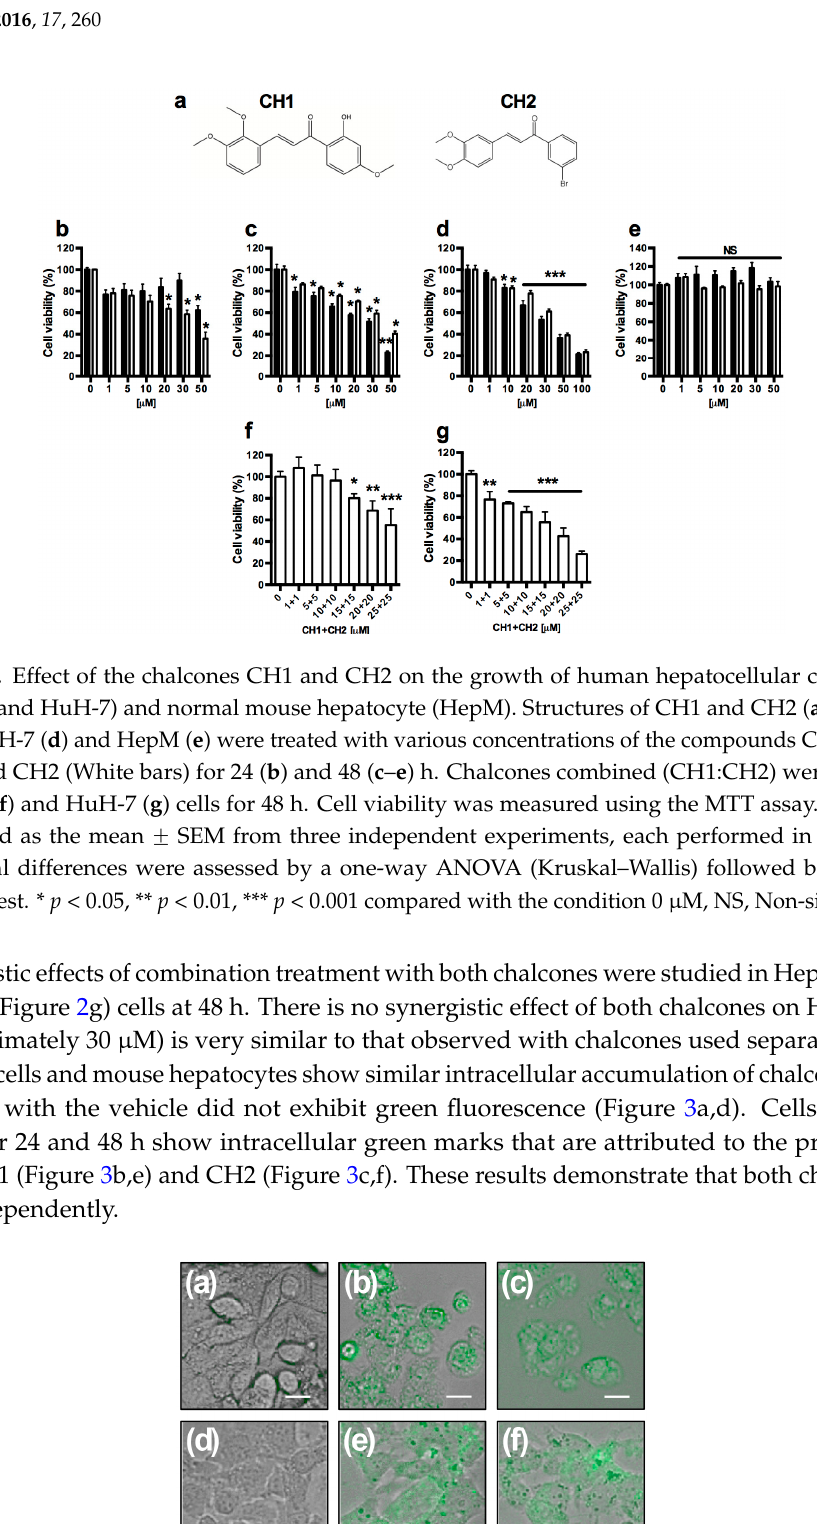
Figure 3. HepG2 and HepM cells exposed to chalcones CH1 and CH2. HepG2 and HepM cells were grown for 24 h, and then treated with each chalcone, independently. Figures show representative phase-contrast images from at least three separates experiments of HepG2 ( a – c ) and HepM ( d – f ) exposed to vehicle (control) ( a , d ); 50 μ M CH1 (green) ( b , e ); and 50 μ M CH2 (green) ( c , f ). Bar scale represents 10 μ m.